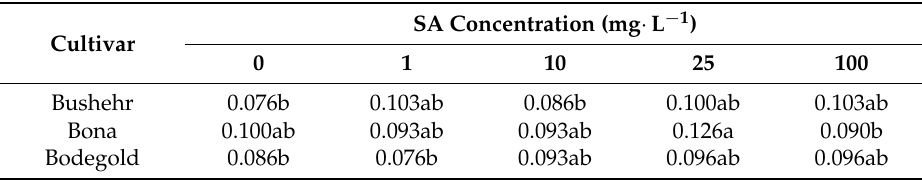
Table 11. Mean comparison for essential oil% ( w / w ) of chamomile treated with salicylic acid under normal conditions.